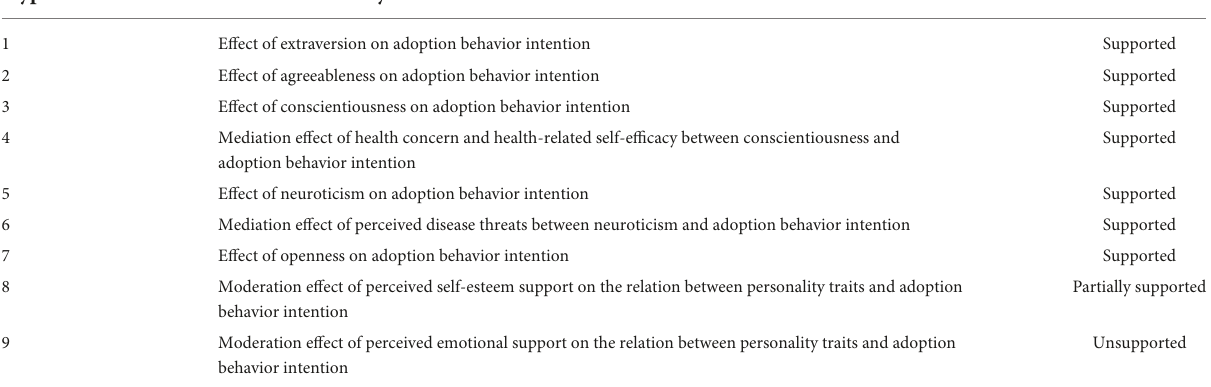
TABLE 12 Hypotheses and